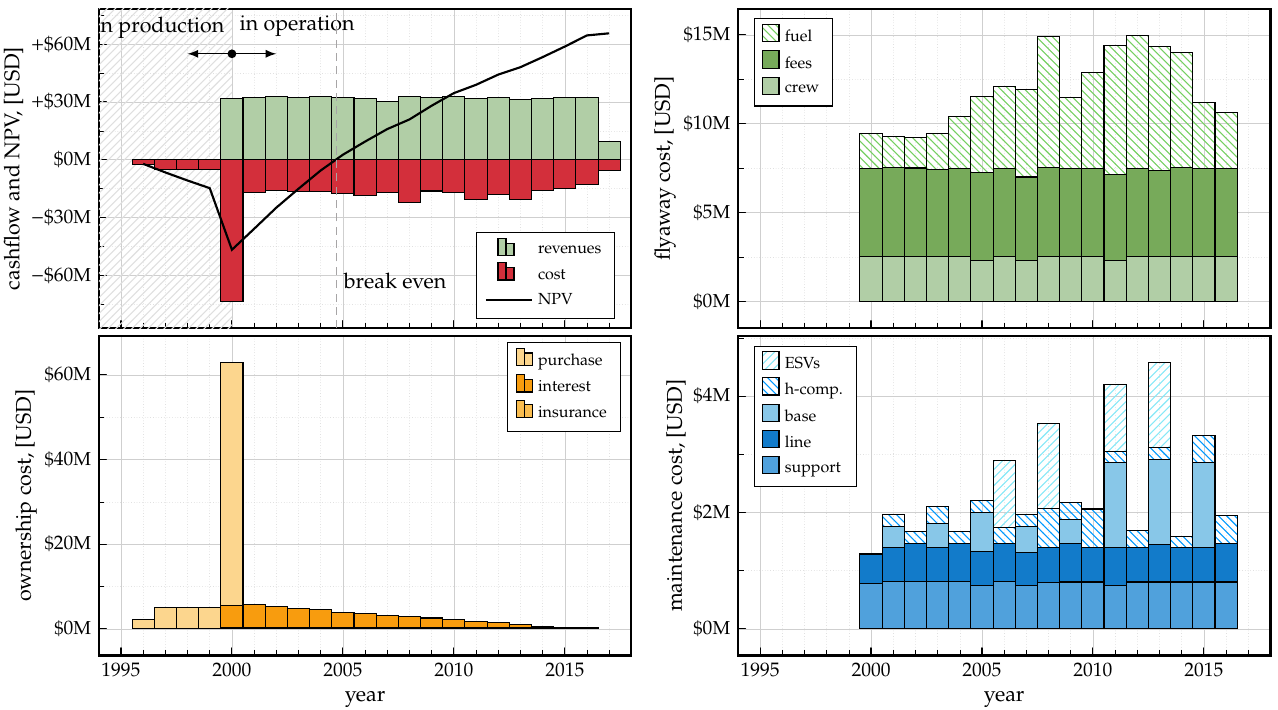
Figure 16. Graphical visualization of overall economics ( top left ), ownership cost ( bottom left ), flyaway cost ( top right ), and maintenance cost ( bottom right